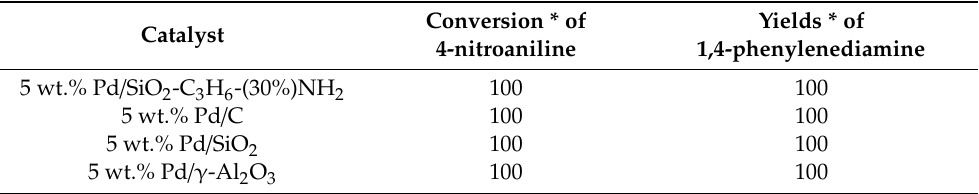
Conversion * of 4-nitroaniline Conversion* of 4-nitroaniline